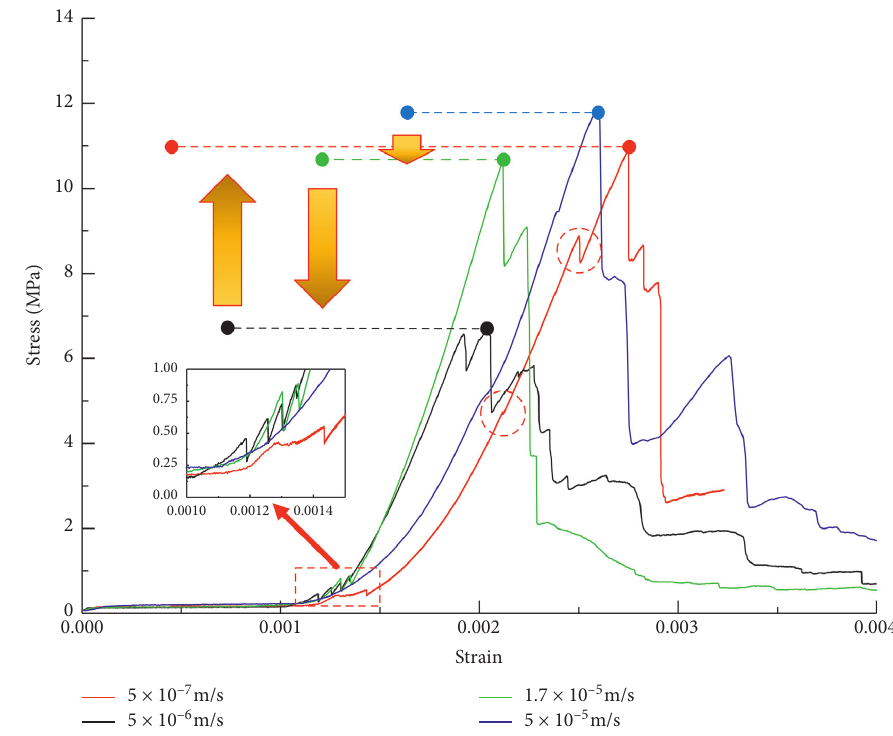
Figure 4: Stress-strain curve under different loading rates.